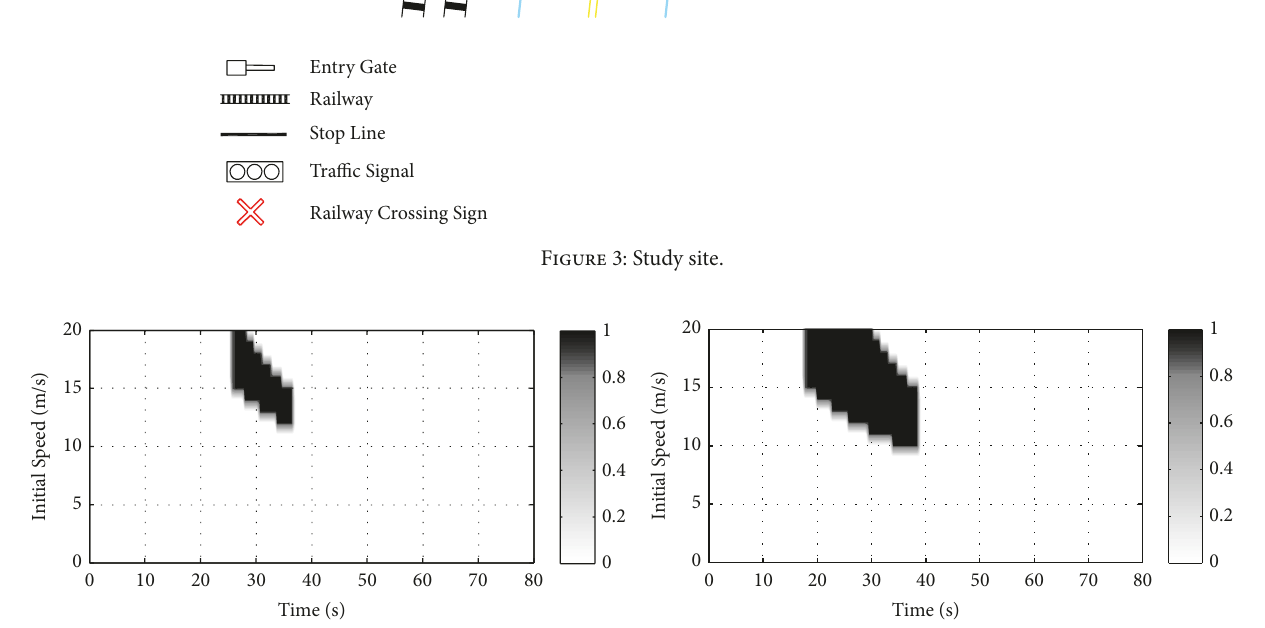
Figure 4: Crossing risk probability for different initial road user speeds. (a) No-control scenario. (b) Control scenario.